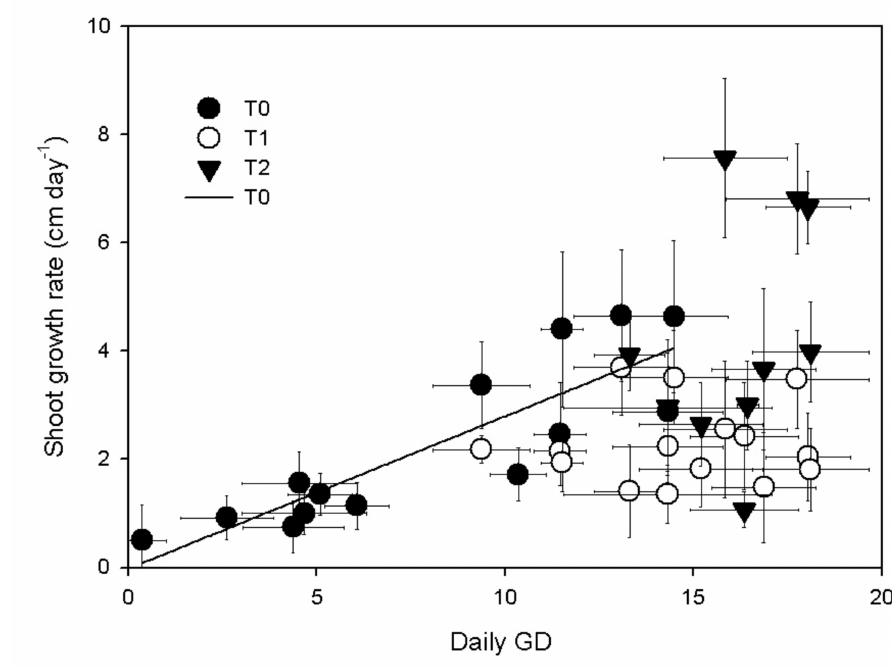
Figure 3. Shoot growth rate vs. mean daily growing degree (GD) in T0 ( Shoot growth rate = 0.28 × Daily GD − 0.02), R 2 = 0.75, p < 0.0001) T1 and T2. Mean ± SE ( n = 4). Shoot leaf area per shoot length increased in T0 and T1 treatments until shoot length was above 37.5 ± 4.5 and 79.7 ± 8.2 cm, respectively, and reached a plateau when the shoots were 110.9 ± 9.9 and 133.7 ± 14.2 cm long before decreasing after in both treatments due to senescence of basal leaves (Figure 4). In T2 shoot, leaf area per unit shoot length (cm 2 cm − 1 ) gradually increased, reaching a maximum value of 11.6 ± 0.7 cm 2 cm − 1 at 151 ± 10.9; in T2 shoot, leaf area per unit shoot length was reduced by about 13% in comparison with the other two treatments.